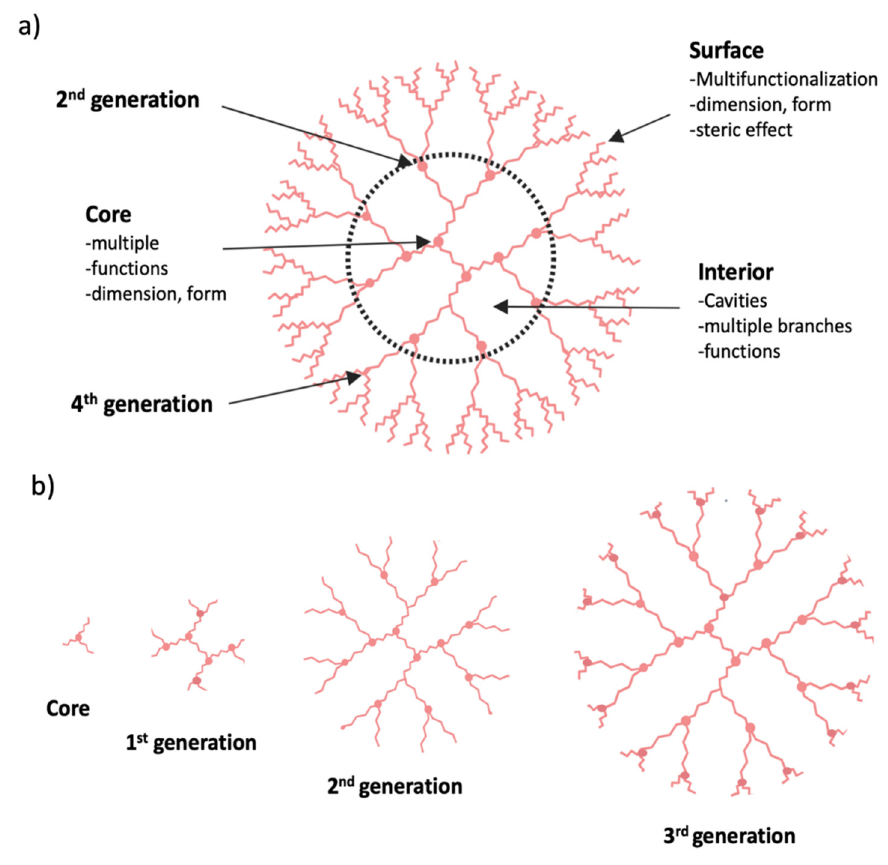
Figure 8. ( a ) Representation of the structure of a dendrimer; ( b ) Different stages of the divergent synthesis of a dendrimer created with Biorender; Adapted from [143], Drug Discovery Today, 2001.